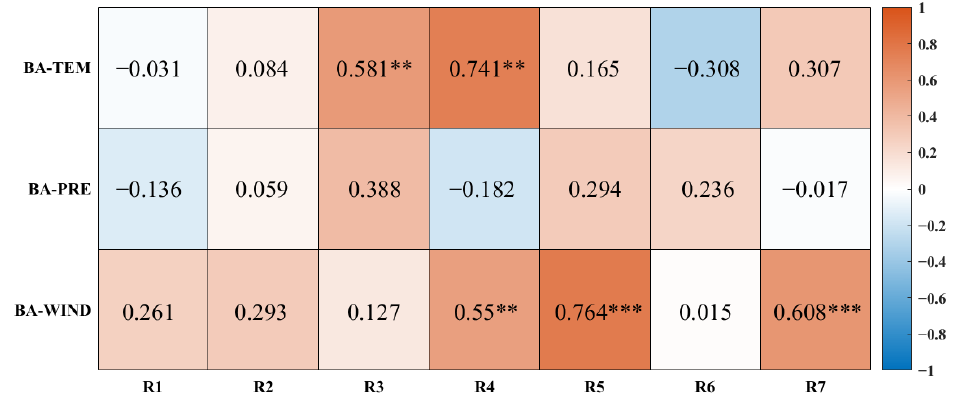
Figure 14. Annual correlation coefficients between BA and temperature, precipitation and wind speed in seven subregions. ** indicates passing the significance test ( p < 0.05), and *** indicates p < 0.01.